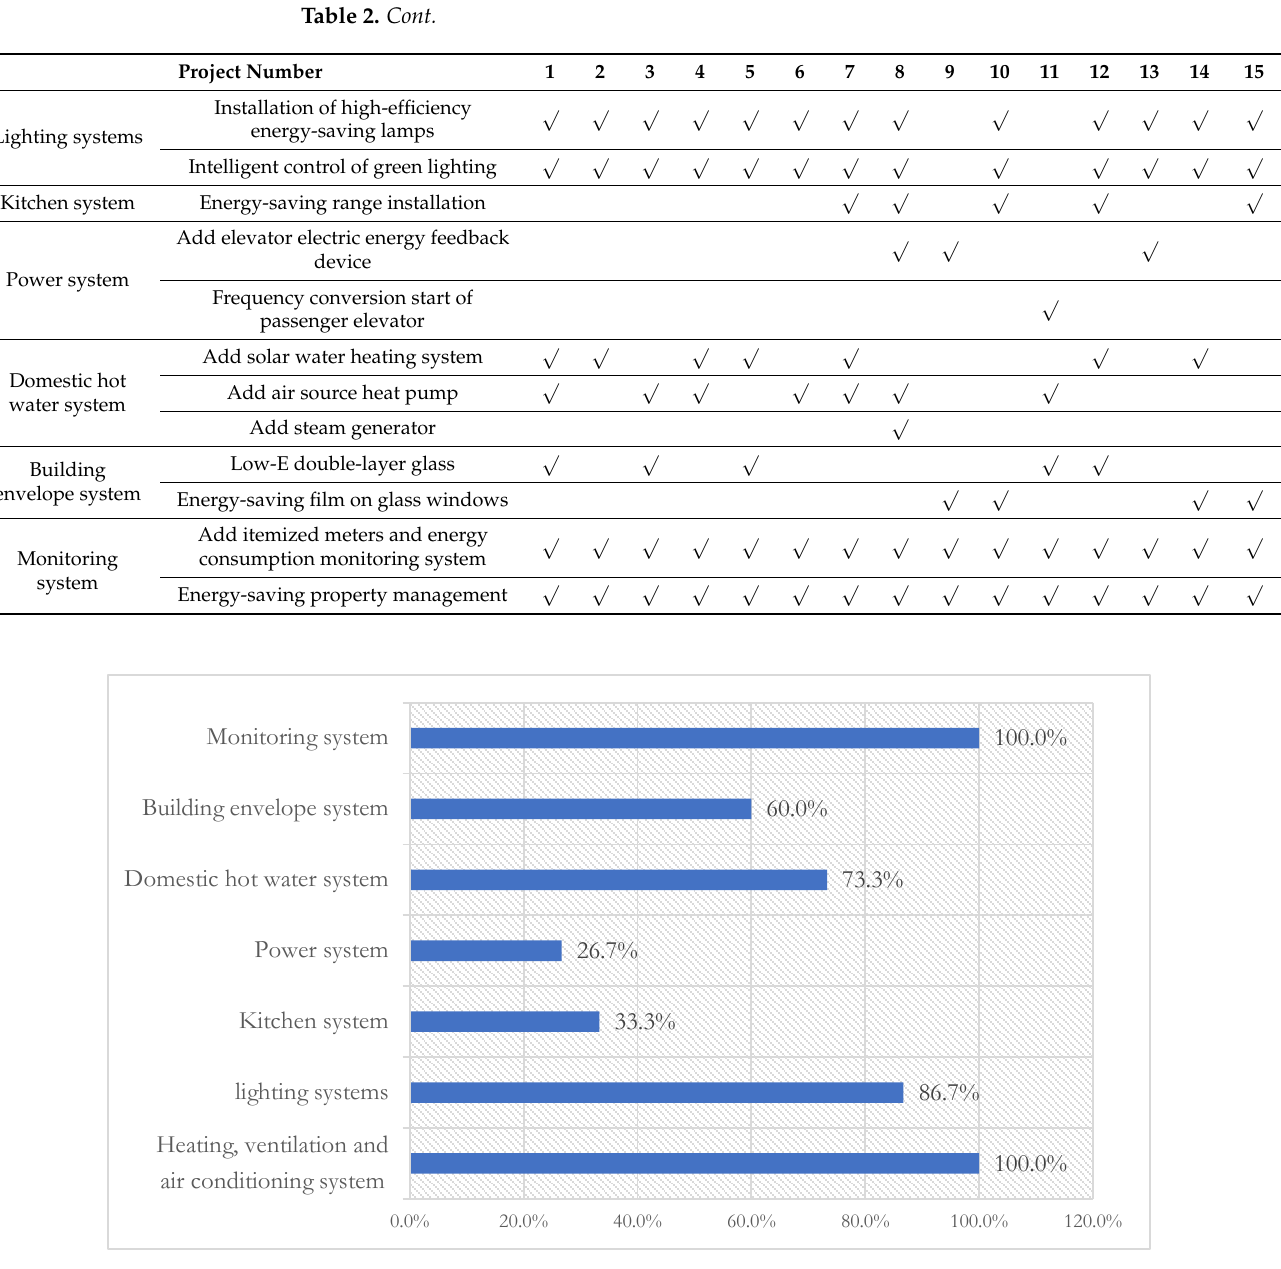
Figure 1. Application scale diagram of energy-saving retrofit technology of existing hotels.